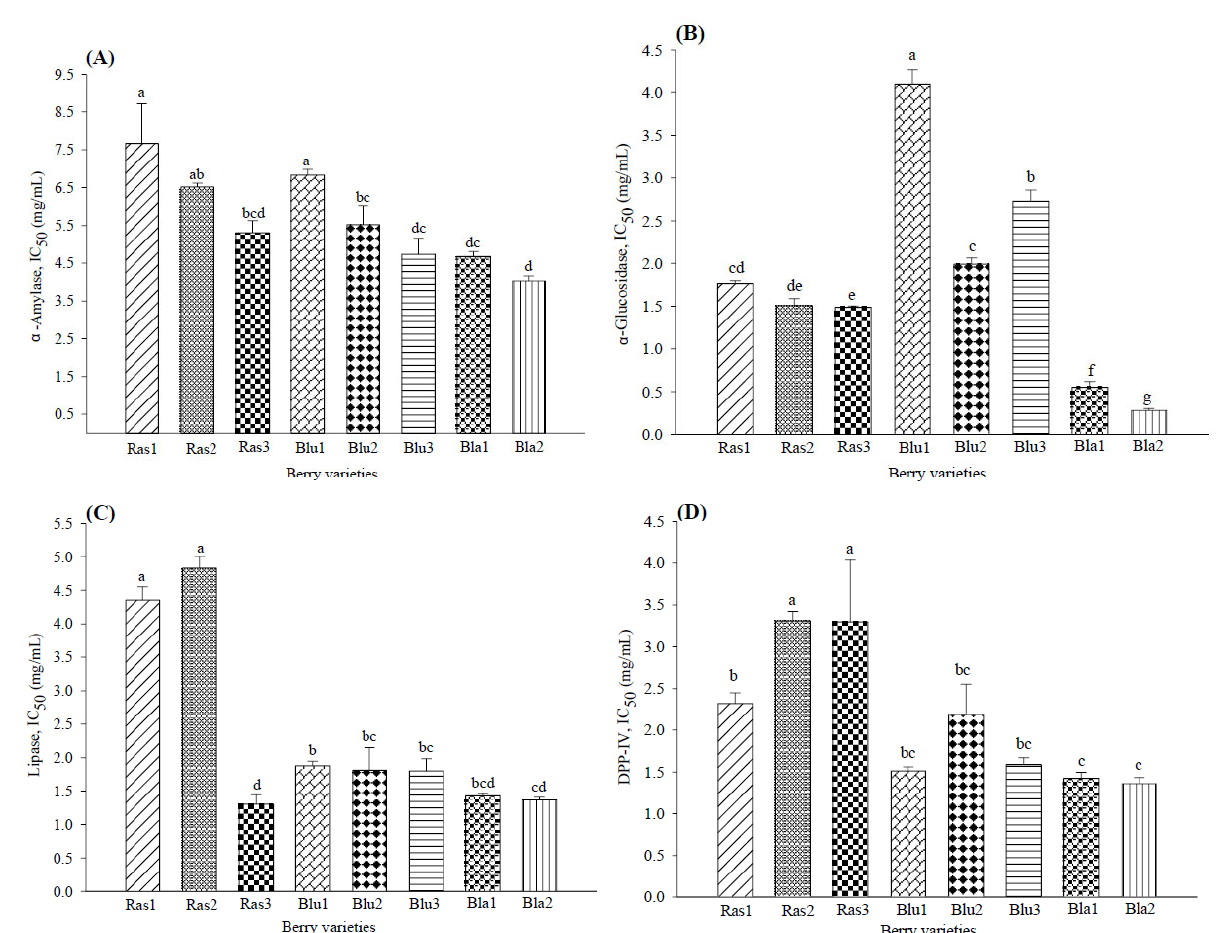
Figure 2. Biological activity of eight varieties of Mexican berries in biochemical assays inhibiting ( A ) α‐ amylase, ( B ) α‐ glucosidase, ( C ) lipase and ( D ) dipeptidyl peptidase IV. Data represent the mean ± SD from three independent replicates. Different letters (a–g) indicate significant difference ( p < 0.05 ) according to Tukey’s test. DPP ‐ IV: dipeptidyl peptidase IV. The IC 50 for pancreatic lipase inhibition (Figure 2C) indicated the highest activ- ity by blackberries (1.36 to 1.42 mg/mL), followed by the Ras3 raspberry variety (IC 50 1.30 ± 0.14 mg/mL) and blueberry varieties (IC 50 1.80 to 1.87 mg/mL), while the lowest ac- tivity was shown by Ras1 and Ras2 (IC 50 4.35 and 4.82 mg/mL). Similarly, McDougall et al. [16] reported that a tannin-rich raspberry extract effectively inhibited pancreatic lipase activity in vitro, while blueberry caused a slight